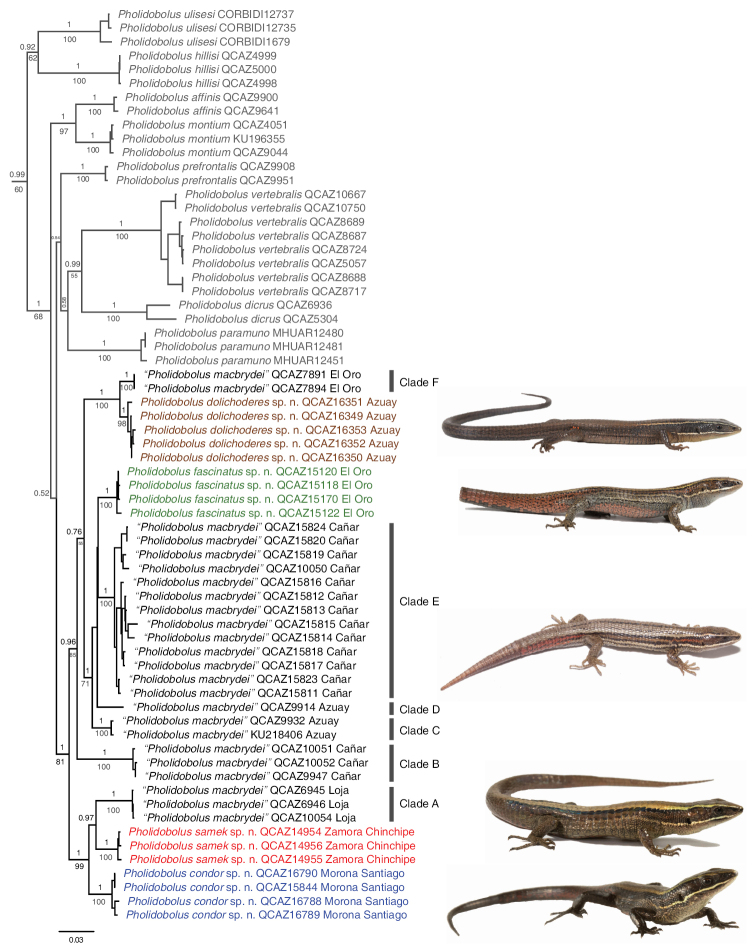
Phylogeny of Pholidobolus. Maximum clade credibility tree derived from a partitioned analysis of 1904 bp of mitochondrial and nuclear DNA. Bayesian posterior probabilities are shown above branches and bootstrap values (RAxML analysis) below branches; values ≤ 0.5 and 50, respectively, are not shown. For clarity, outgroup taxa and values on short branches are not shown. Species outside the “P.
macbrydei” complex are in grey; new species described in this paper are in color matching the distribution records of the map in Figure 7. The species name followed by voucher number and province (“P.
macbrydei” complex only) are provided for each terminal. Photographs from top to bottom: P.
dolichoderes sp. nov. holotype, P.
fascinatus sp. nov. holotype, “P.
macbrydei” (Clade B) QCAZ 15824, P.
samek sp. nov. holotype, P.
condor sp. nov. holotype.